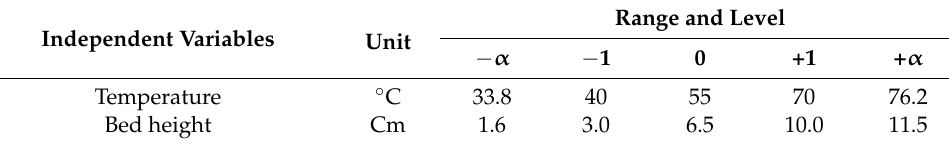
Table 2. Experiment design: experimental ranges and various levels of the variables for continuous system